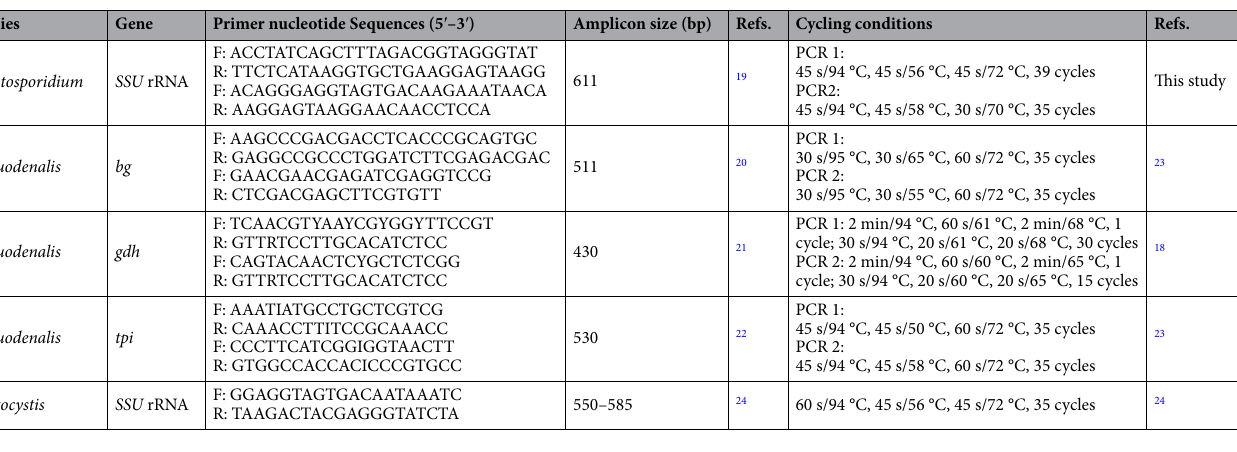
Table 1. Genetic markers, Primers, and PCR amplification schemes for detecting and characterizing Cryptosporidium spp., Giardia duodenalis, and Blastocystis sp. in the fecal samples of cats and cat owners in Tehran,